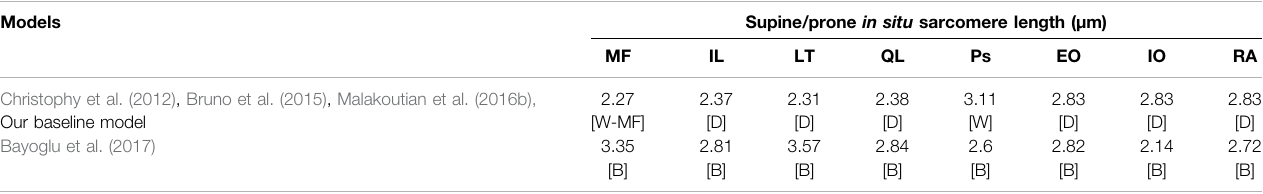
TABLE 2 | Difference in lumbar spine models with regard to the sources of supine/prone in situ sarcomere length values taken from the literature.